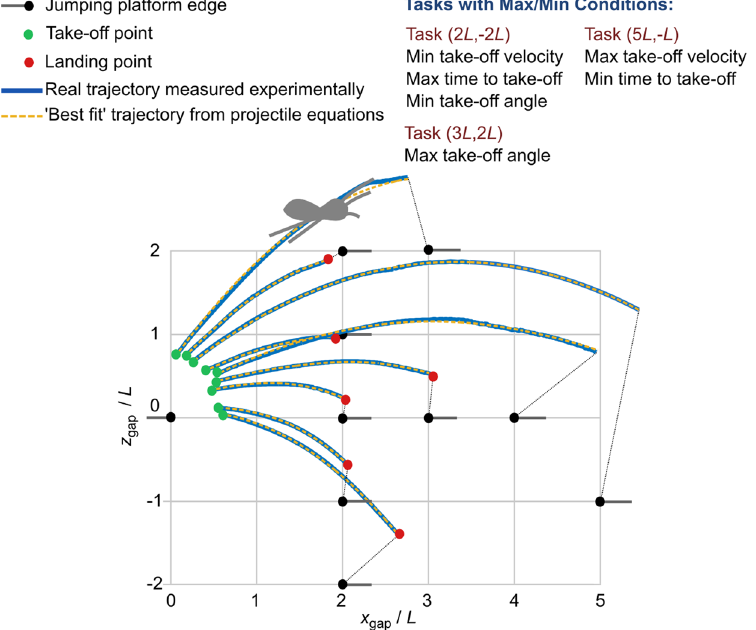
Figure 3. Example jump trajectories. Green circles indicate the location of the centre of mass at take-off. Red circles represent the location of the centre of mass at landing. No marker at the end of the trajectory indicates that the spider left the measurement field of view before landing. Leader lines from the ends of each trajectory indicate the landing platform location for that particular task. Background grid squares have dimensions L × L where L is the spider reference length ( L = 15 mm). Blue lines are examples of the experimentally measured trajectories. Orange dashed lines are the calculated trajectories based on ‘best fit’ between projectile equations and experimental